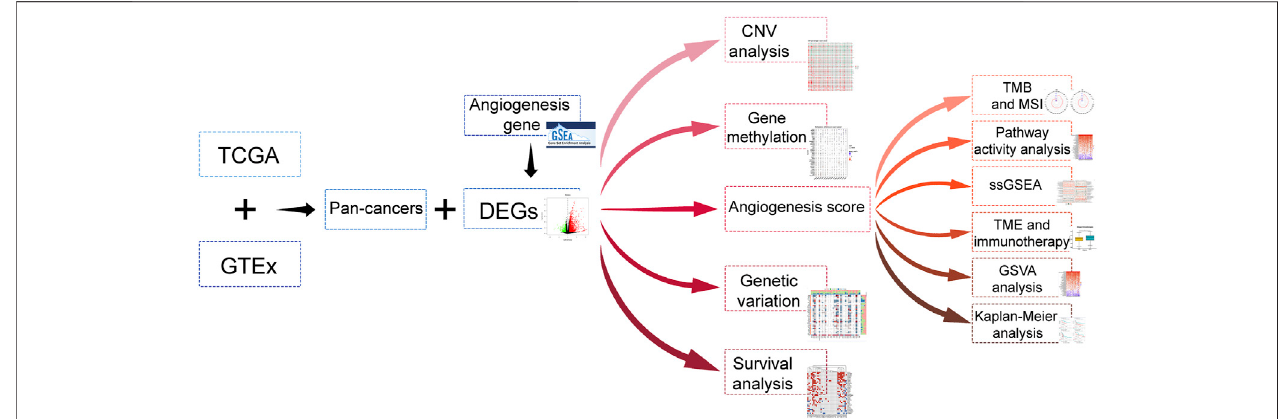
FIGURE 1 | Article fl ow